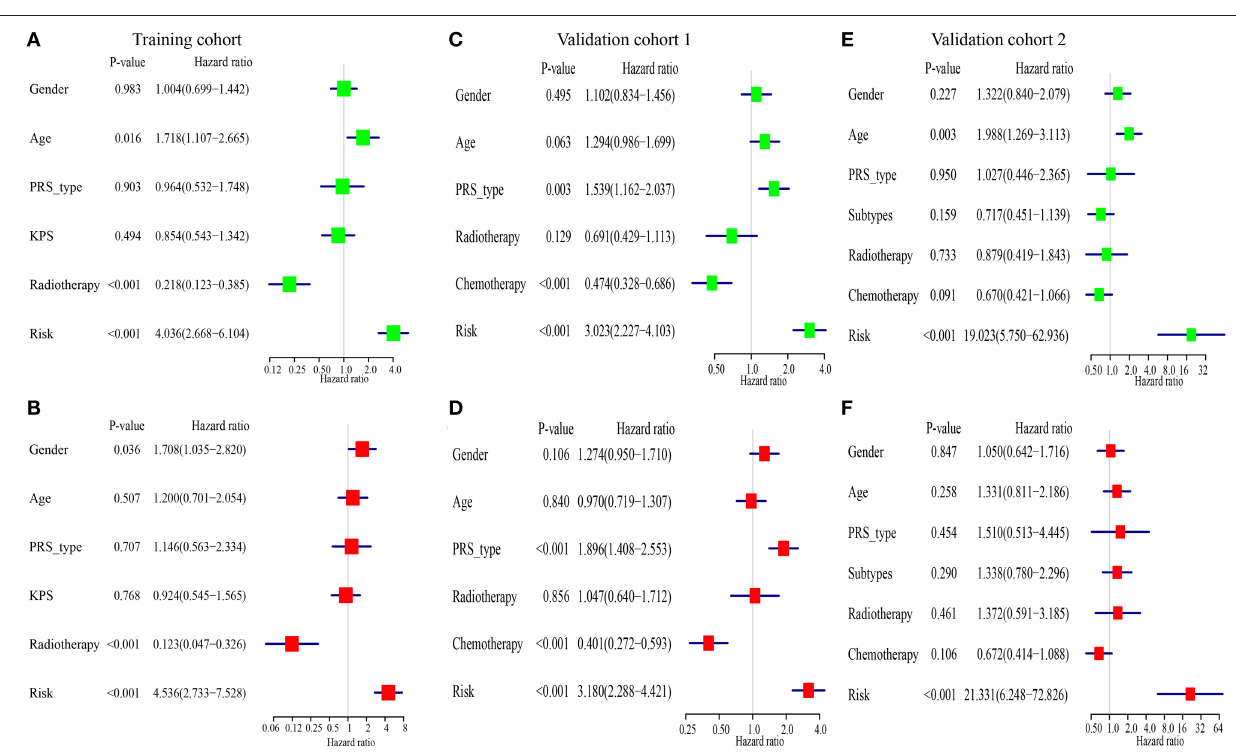
FIGURE 5 | The immune-related gene pairs (IRGPs) signature is an independent prognostic factor of overall survival (OS) of patients with glioblastoma (GBM). (A,B) The result of univariable and multivariable Cox regression analysis in the Training cohort. (C,D) In Validation cohort 1. (E,F) In Validation cohort